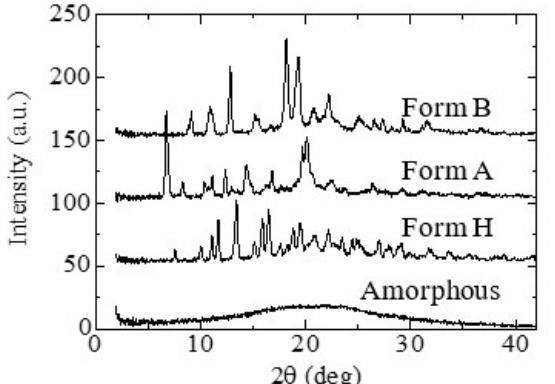
Figure 4. TG diagrams of crystals obtained from aqueous solution (solid curve) and 80% ethanol solution (dotted curve). Refer to the text about the belonging of weight.